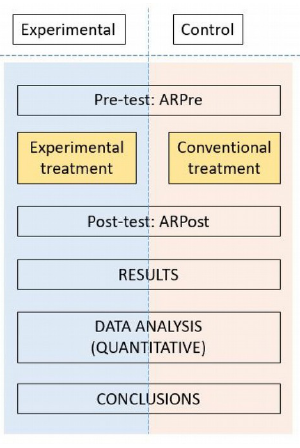
Figure 2. Research